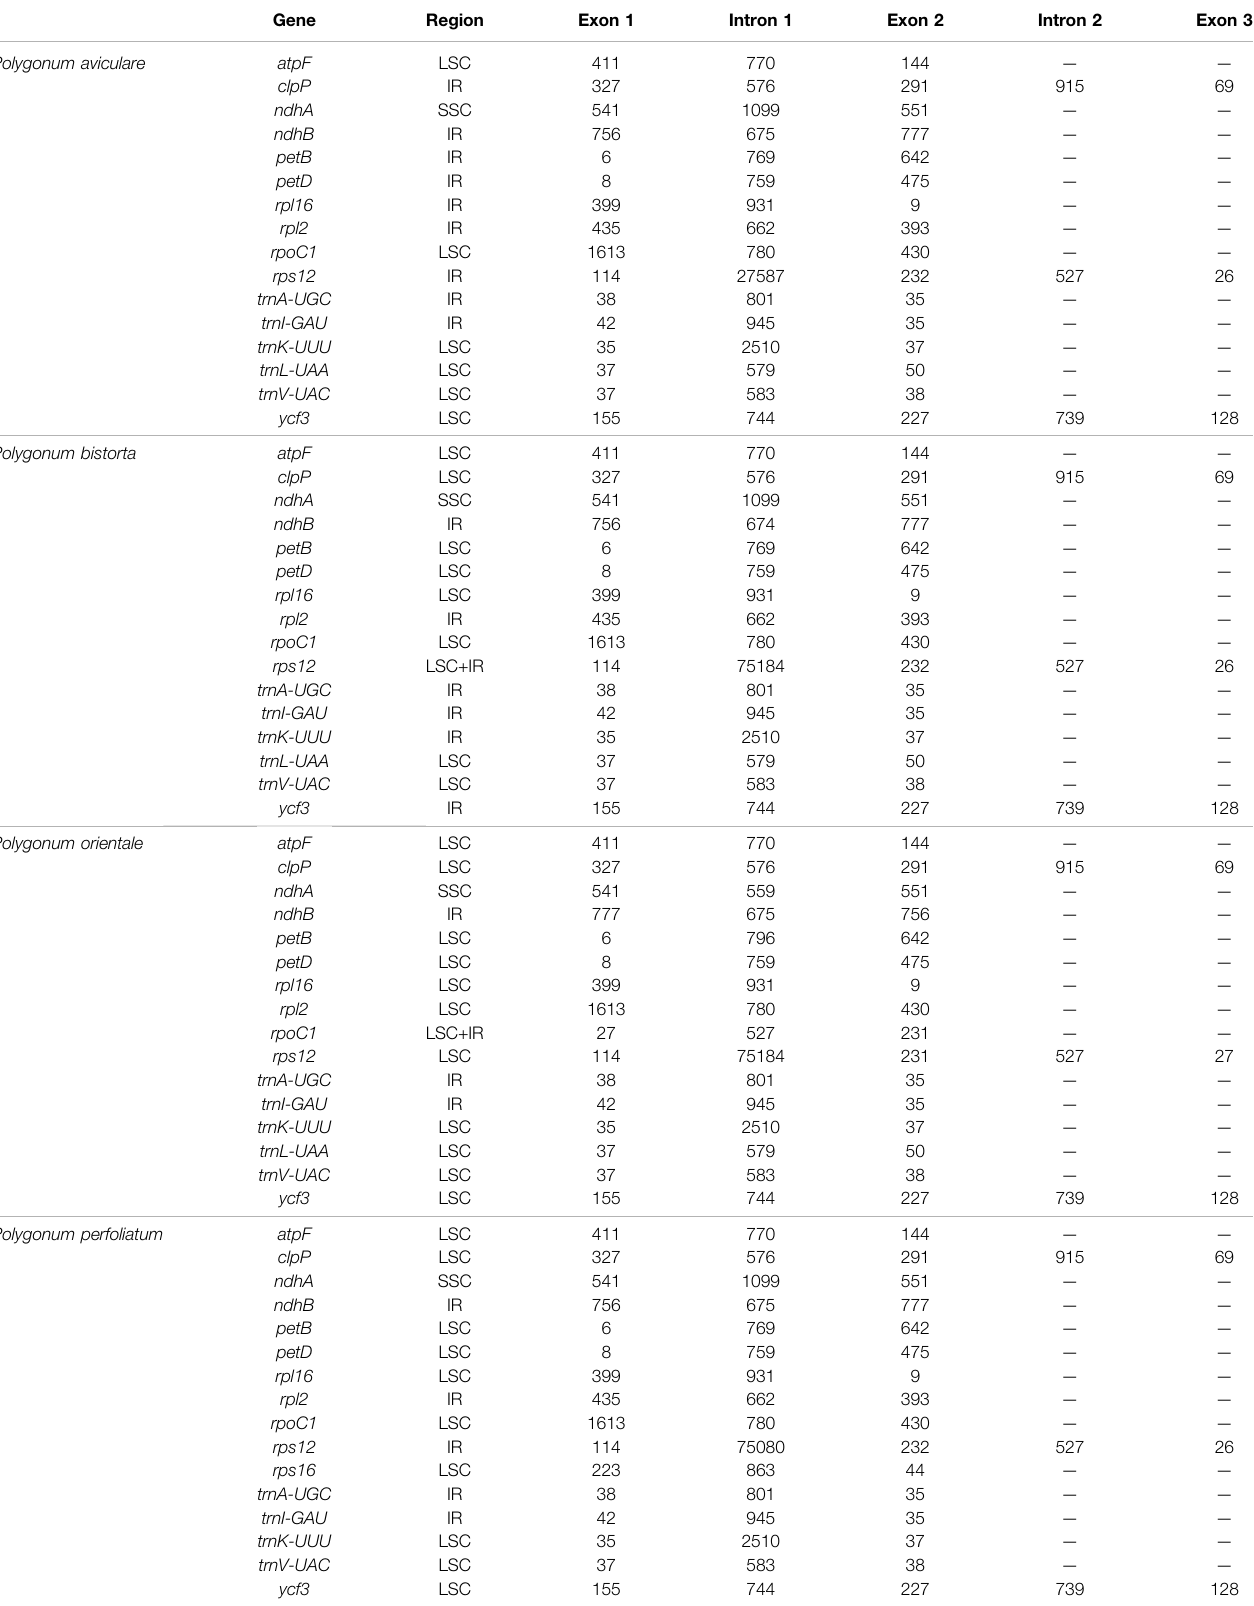
TABLE 3 | Length of exons and introns in four Polygonum chloroplast